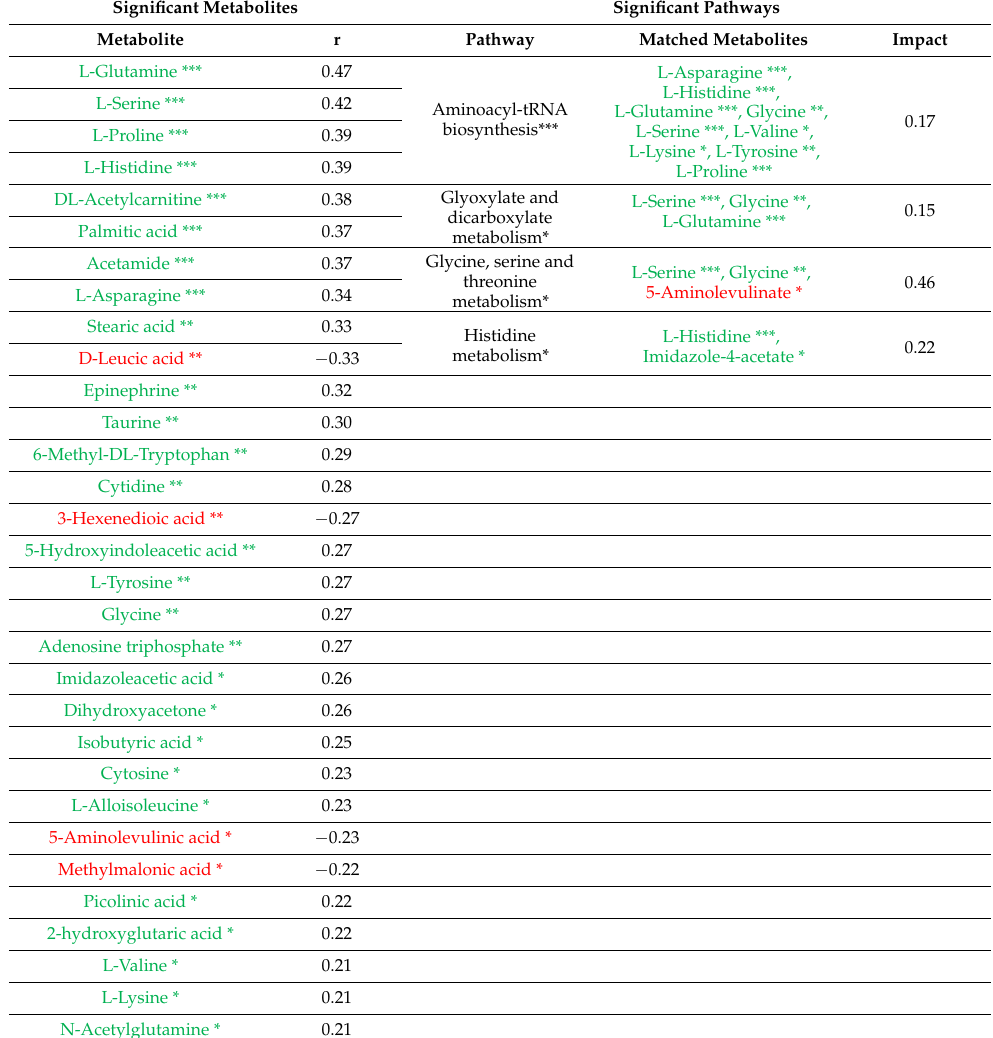
Table 15. Metabolites and their pathways which correlate with a marker of